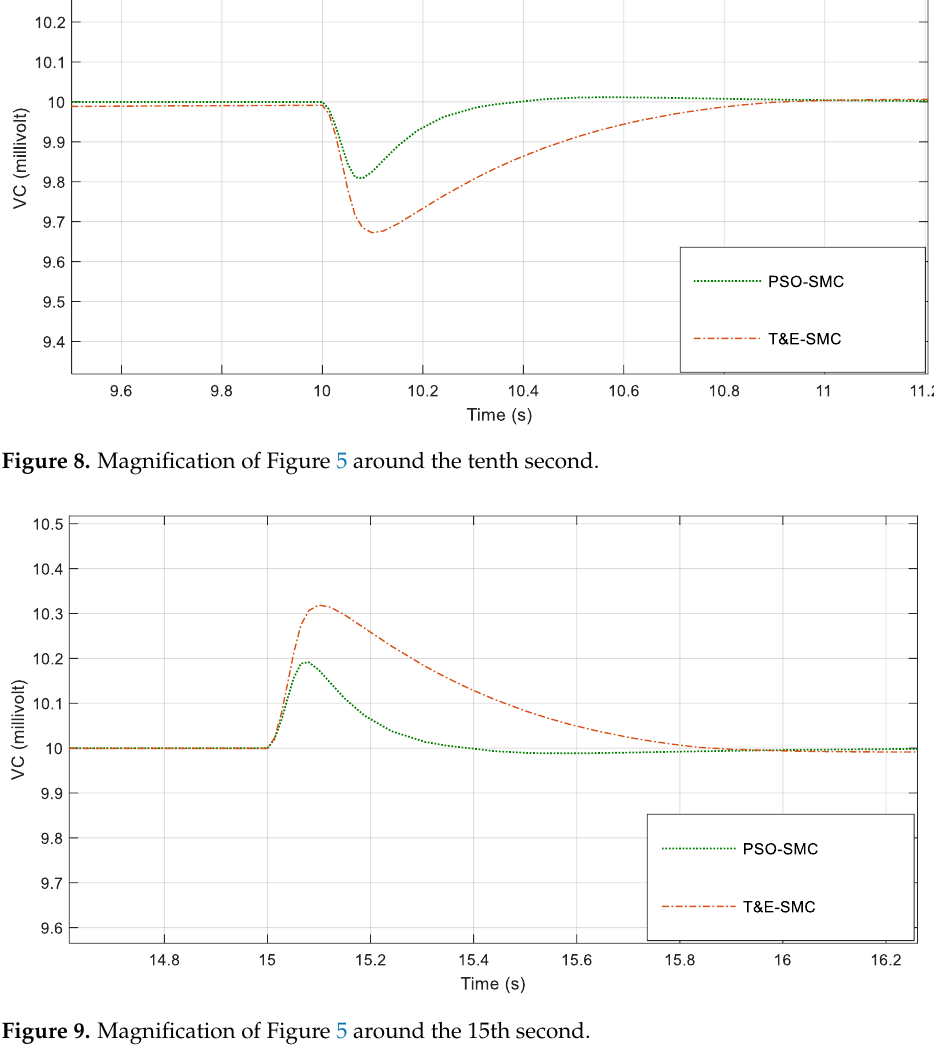
Figure 9. Magnification of Figure 5 around the 15th second.